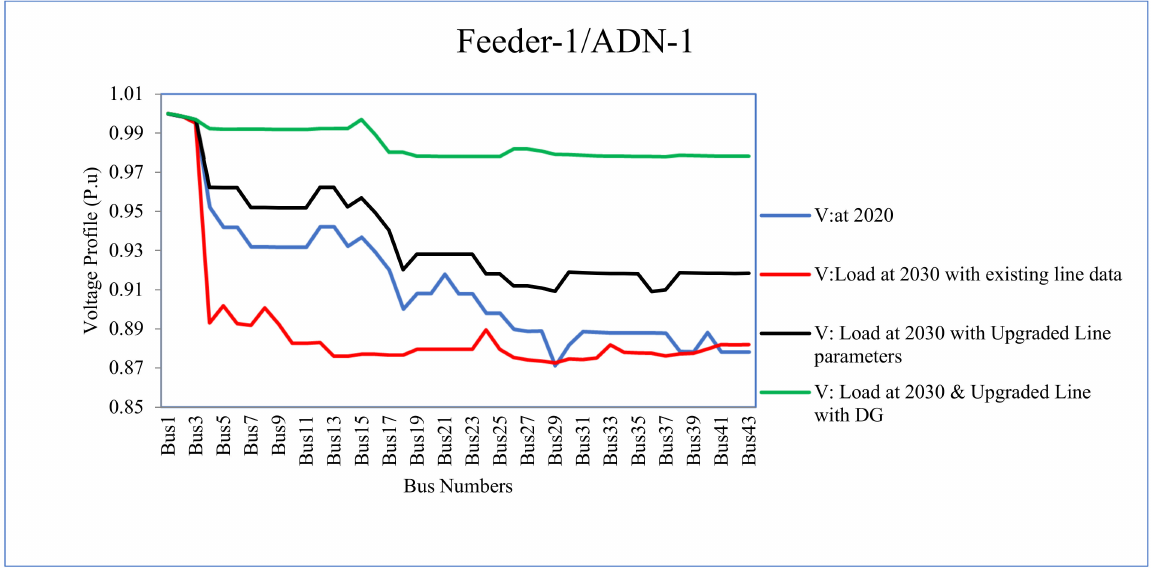
Figure 10. Voltage profiles of Addis North feeder-1 with different